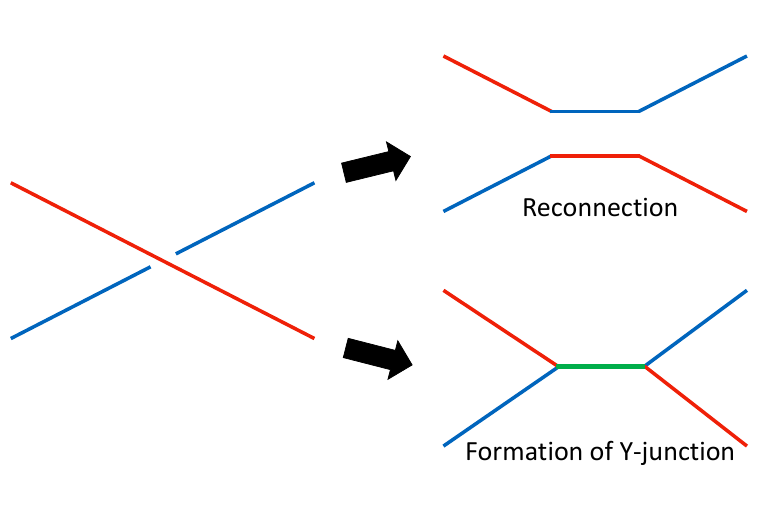
Figure 6 . Reconnection process and formation of a